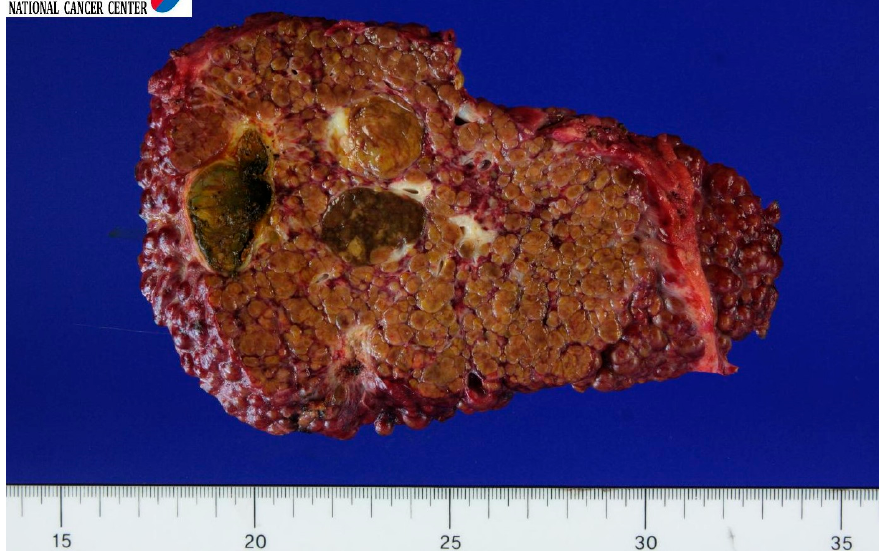
Figure 1. Gross specimen of the whole liver explant showing multiple hepatocellular carcinoma nodules and cirrhosis at the time of the first transplantation.